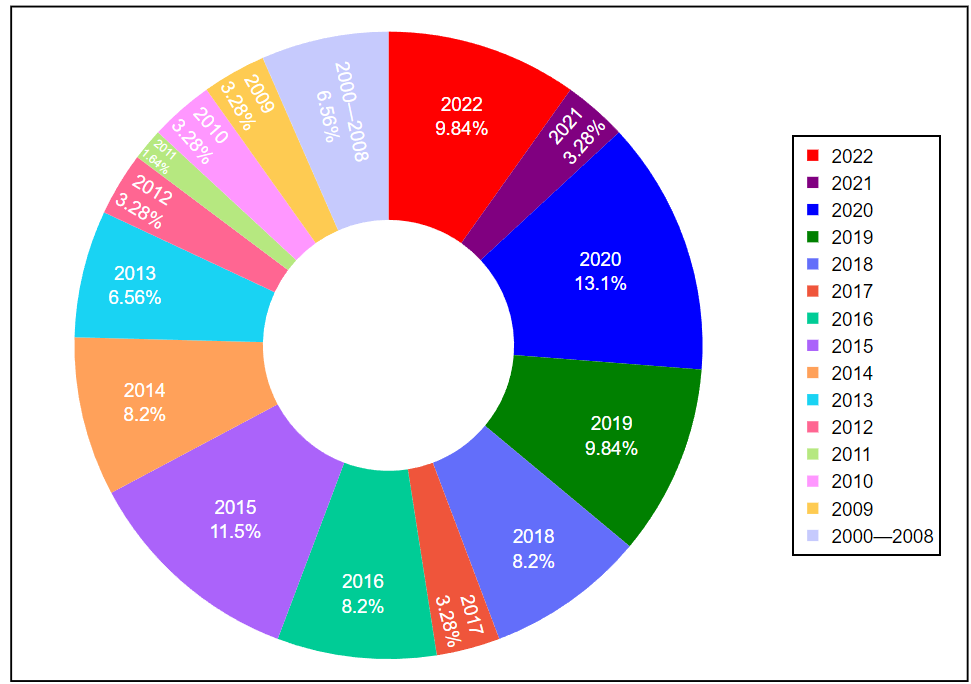
Figure 1. Distribution of the reviewed studies by the publication year in percentage.